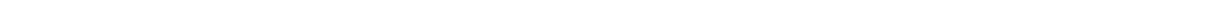
Fig. 6 ZUFSP is a K63-selective deubiquitinase. a – c Tetra-Ub chain cleavage assays to test activity and selectivity of recombinant full-length ZUFSP a , full- length ZUFSP puri fi ed from HEK 293T cells b , and recombinant catalytic domain of ZUFSP c . ZUFSP (1.1 µ M) and Ub chains (2.2 µ M) were incubated for 1 h at 25 °C, then analyzed by SDS-PAGE and silver staining. d Time-course analysis of ZUFSP-mediated depolymerization of K48- and K63-linked tetra- ubiquitin conjugated to a TAMRA-labeled peptide, monitored by in-gel fl uorescence. Figure is representative of two independent replicates. It is noteworthy that this method detects only species bearing a TAMRA fl uorophore, and not the distal fragments formed after cleavage, in contrast to silver stains that detect all protein species. e Surface representation of K63-linked di-Ub and K48-linked di-Ub. The color-coding shows residues exhibiting 15 N differential line broadening (DLB) in red and 13 C DLB in green. Residues were colored if the lines broadened completely (signal disappearance) or the line widths were more than doubled. These DLB effects were observed upon titration of unlabeled catalytically inactive full length ZUFSP C360A -His 6 to differentially labeled 15 N-proximal 13 C-distal K48- or K63-linked di-Ubiquitin. K48-linked di-Ubiquitin structure from pdb entry 2kde, K63 di-Ub